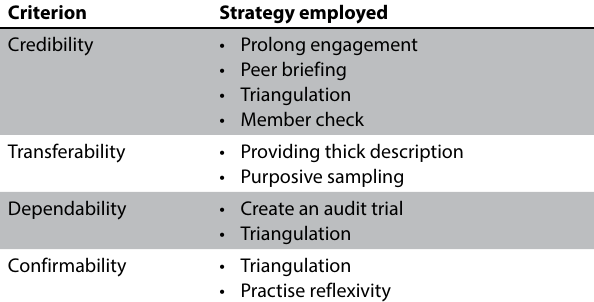
Table 1: Criteria for trustworthiness of qualitative research